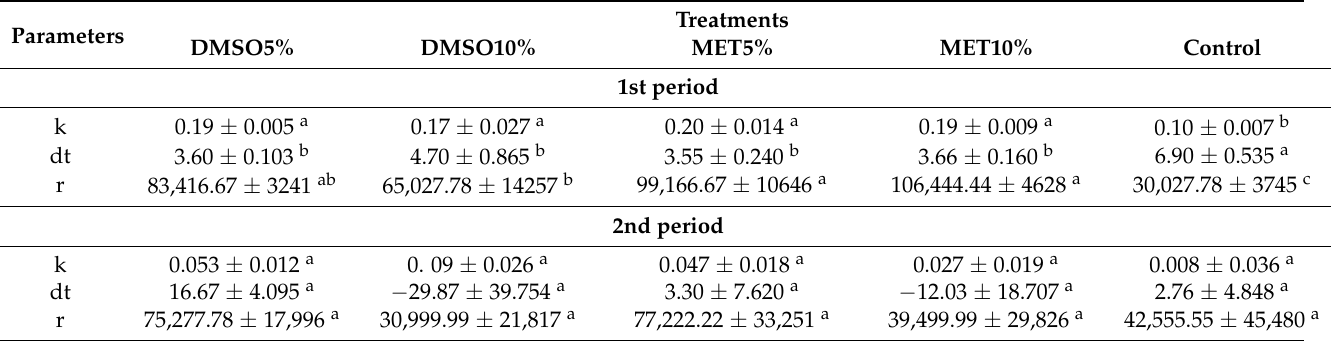
Table 5. Production parameters of the microalgae Scenedesmus sp. ( ± standard error) post-thawing: k, instantaneous growth rate; dt, doubling time; r, yield. Different letters between rows indicate a statistically significant difference ( p < 0.05) between